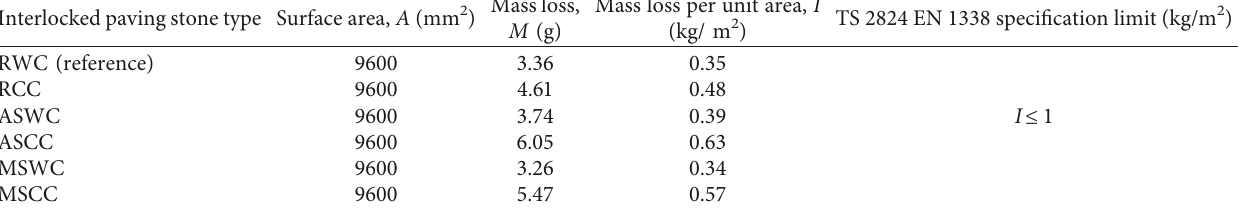
Table 20: Results of the freeze-thaw test results of interlocked paving stones.